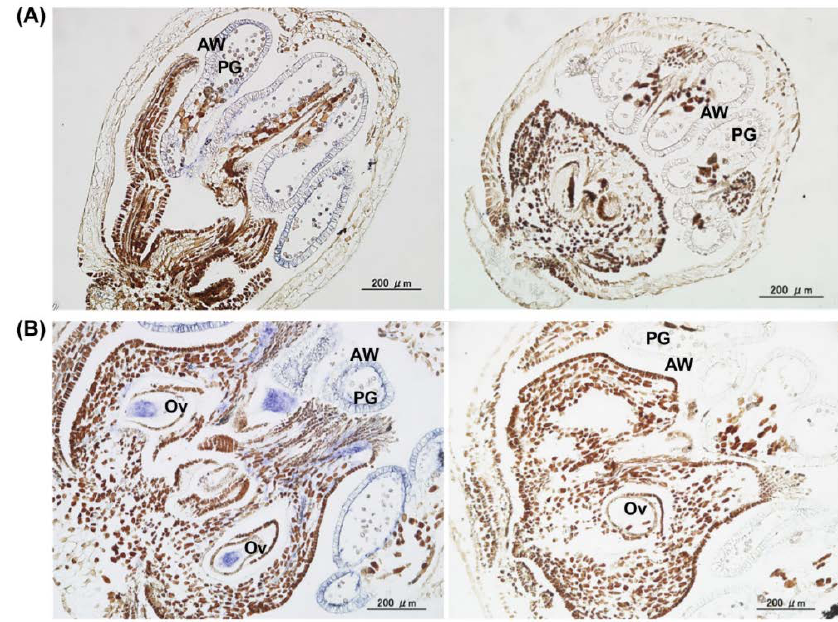
Figure 7. In situ hybridization analysis of ALSV distribution in the flower organs of Ganebu and F 1 hybrid (G × N, line 240-1) plants infected with ALSV-AtFT/VvTFL1A. ( A ) Male flower of Ganebu treated with the ALSV-Vp24 ( − ) probe (left) and SMV-P1 ( − ) probe (right) as a control. ( B ) ALSV distribution in bisexual flowers in the F 1 hybrid (G × N) detected with an ALSV-Vp24 ( − ) probe (left) and SMV-P1 ( − ) probe (right) as a control. Blue colour indicates ALSV distribution. AW; anther wall, PG; pollen grain, Ov; ovary.